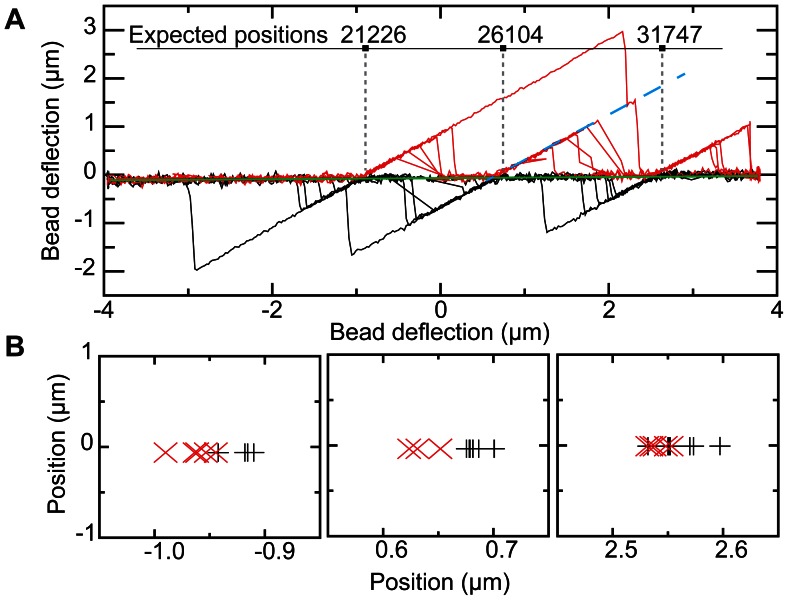
Detection of DNA-bound EcoRI proteins.(A) 7 consecutive scans superimposed (red lines forward scans, black lines backward scans, data from a single molecule is shown). Protein positions (grey dashed lines) were determined from the intersection of linear fits to the baseline (green line) and individual identified spikes (blue dashed line). Expected positions based on the DNA sequence are indicated at the top, numbers indicate sequence position in bases. (B) Protein position determined from the forward (red crosses) and backward scans (black crosses) of panel A. EcoRI positions are systematically detected slightly to the left in forward scans compared to the positions detected in the backward scans.